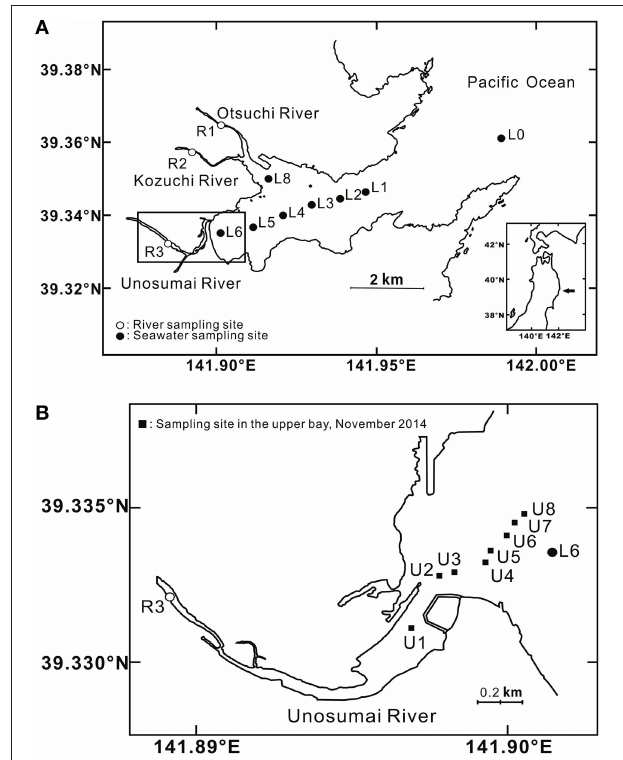
FIGURE 1 | (A) Sampling sites in the three rivers in the catchment basin and in Otsuchi Bay (B) mid-salinity stations in the upper bay near the mouth of the Unosumai